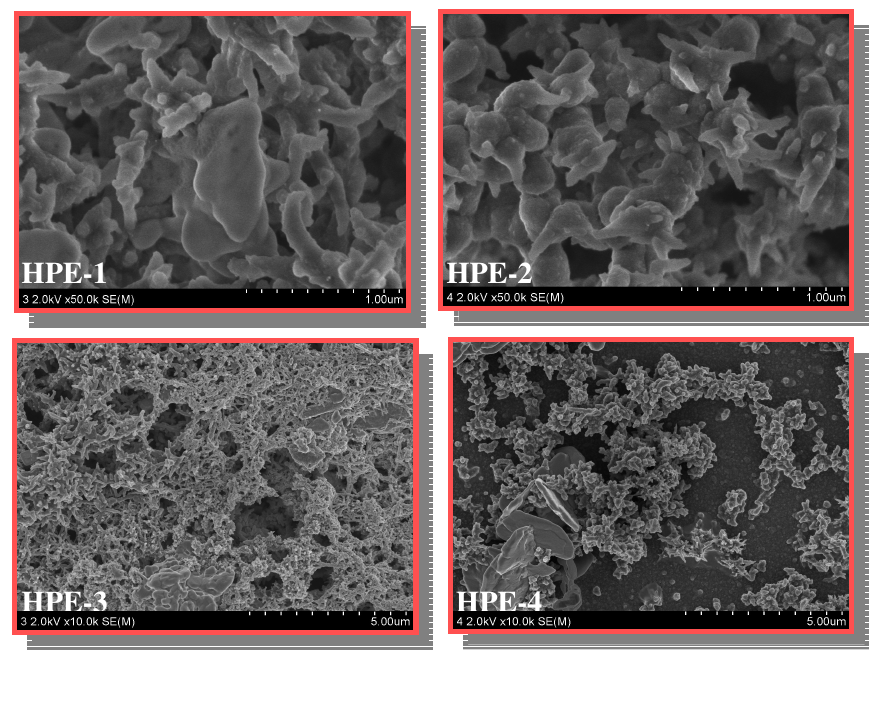
Figure 3. SEM images of prepared by physical entrapment of HRP (HPE-1 and HPE-3) and covalent functionalization (HPE-2 and